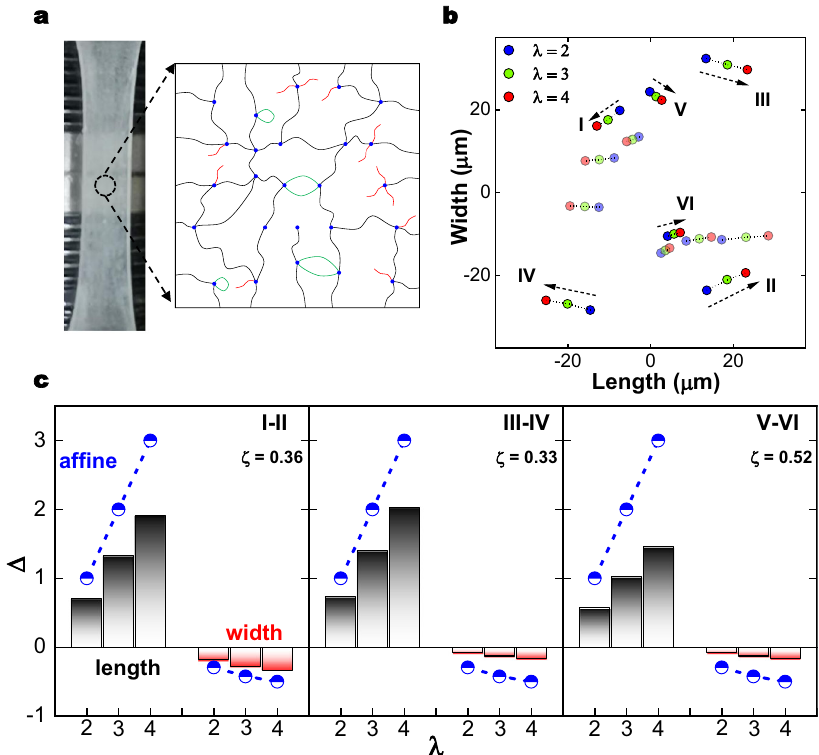
Fig. 2 | Comparing macroscopic and local deformations. a A representative photo of a network stretched to λ =4, accompanied by a sketch of possible local imperfectionsofnetworkstructure,withcrosslinks,polymerstrands,anddangling chains/loopsindicatedbyblue,black,red,andgreencolors,respectively. b Atthree elongation ratios, positions in the length and width directions are mapped for 6